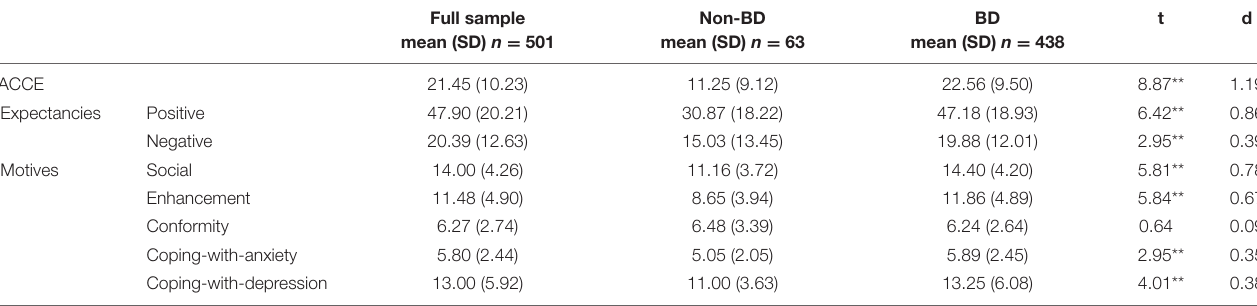
TABLE 2 | Mean scores on each bing drinking subscale and between-group